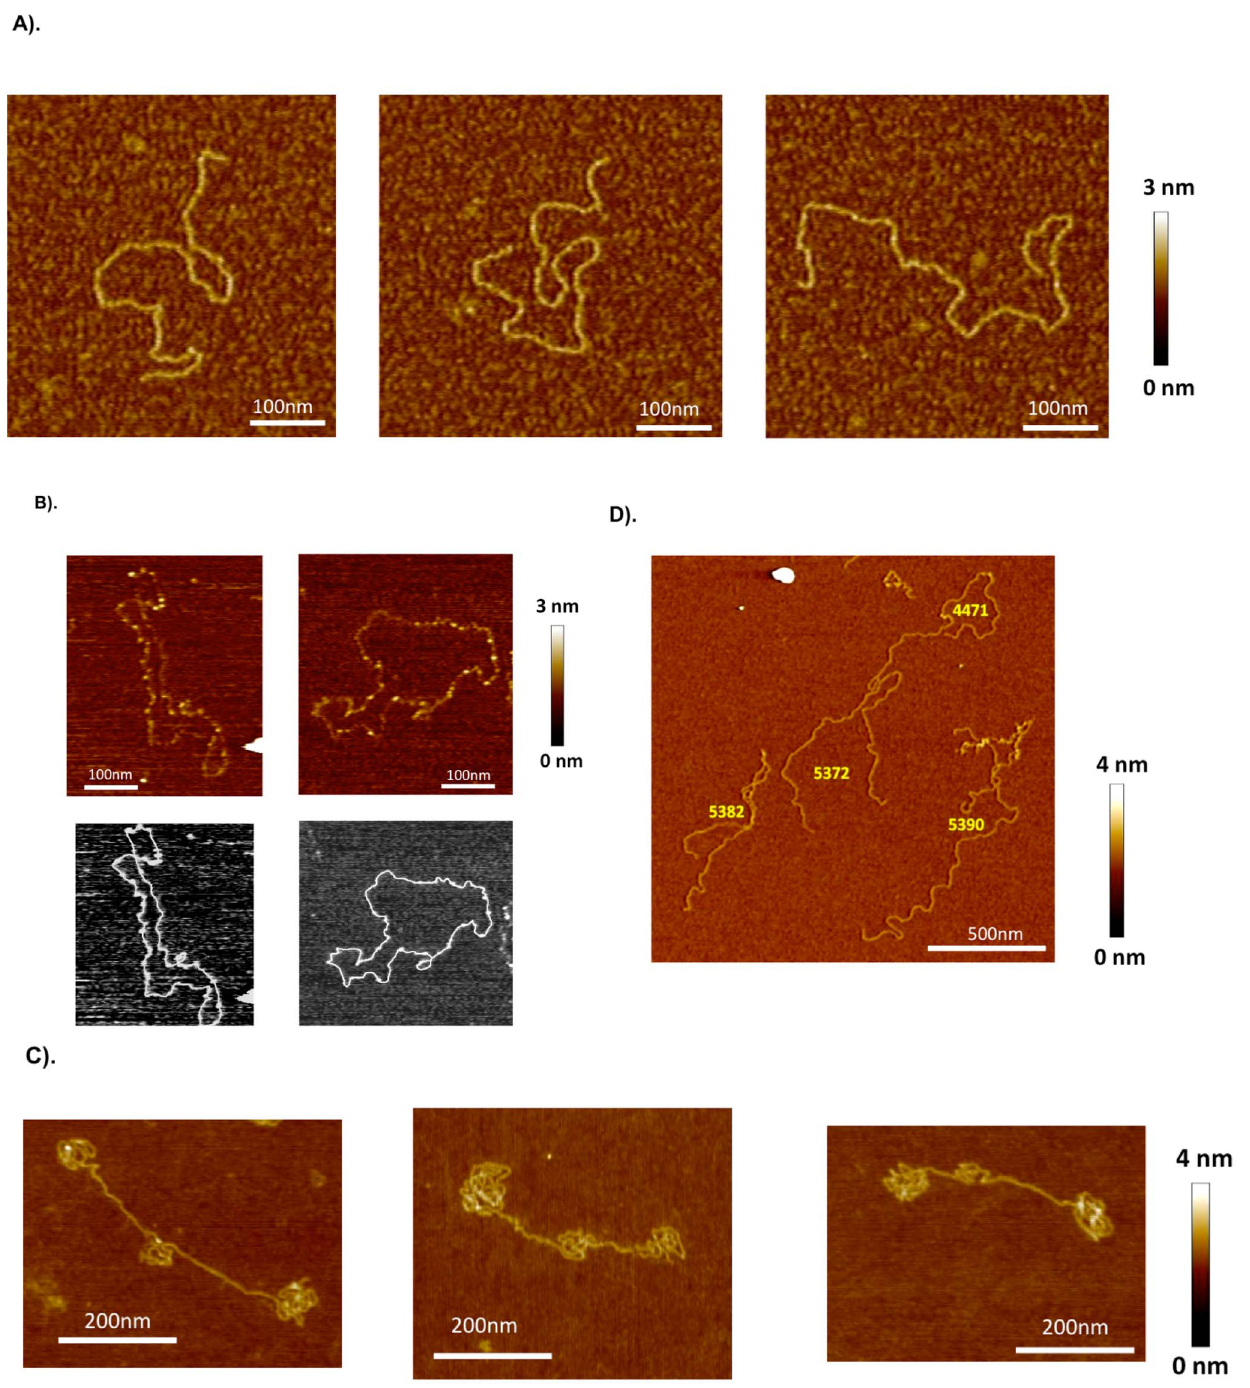
Figure 6. AFM images of CELiD vector DNA chains adsorbed onto APS-treated mica. (A) Typical images of the CELiD-GFP monomer deposited from aqueous solution (dH 2 O). The monomer is indistinguishable from standard double-stranded, linear DNA. All images are 450 6 450 nm. (B) CELiD-GFP monomers adsorbed onto mica substrate immediately after being exposed to denaturing conditions. The height of the chain is about half that of the native monomer chain confirming that the loops are single-stranded. These monomers are closed loops with randomly located, condensed regions (brighter spots along the loops). The lengths of these loops are consistent with denatured monomers supporting the model of a covalently closed, duplex conformation under native conditions. Top images are of the denatured monomers. Bottom images show the corresponding traced loops. (C) Images of individual CELiD-GFP dimers adsorbed from H 2 O. The chains are double-stranded, linear DNA with lengths twice that of the monomer and exhibit a characteristic conformation with three condensed regions, one located centrally and the other two at opposite ends of the molecule. (D) Under high salt conditions (0.5 M NaCl), the condensed regions of the CELiD-GFP dimer relax and the chains take on conformations typical of double-stranded, linear DNA with length twice that of the monomer CELiD vector DNA. Numbers in yellow indicate the chain length in bp, estimated by path tracing.